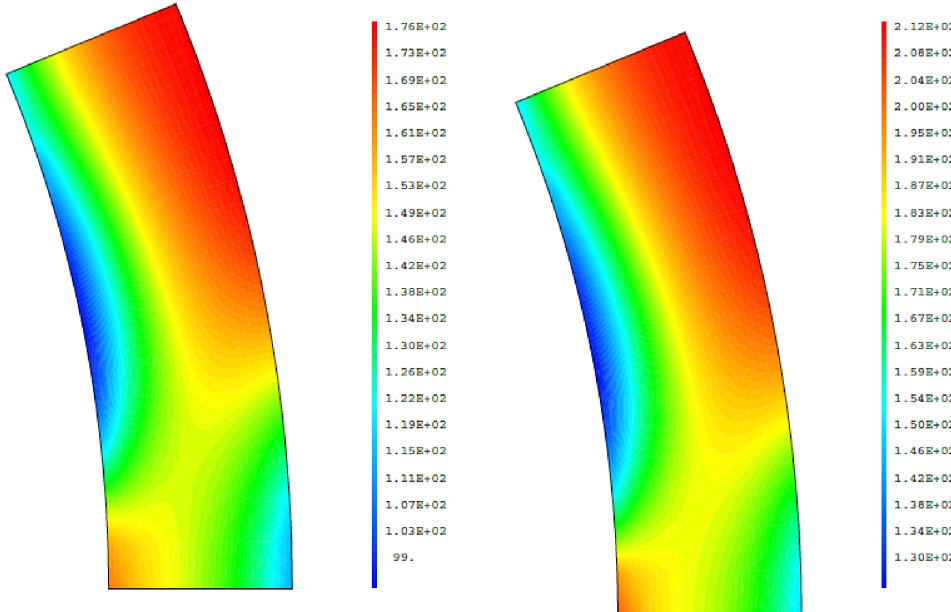
Fig. 3. Hoop stresses (in MPa) calculated in the cladding 5 ms (left) and at the time of the microphone event attributed to the cracking of a hydride blister at PPN (right).